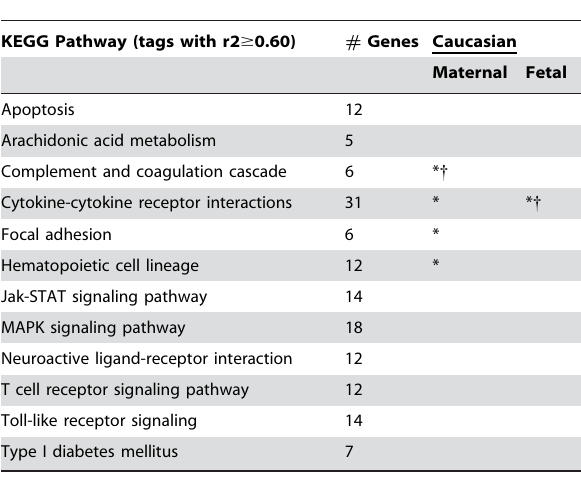
Table 8 . Significant results by KEGG pathway using only tags